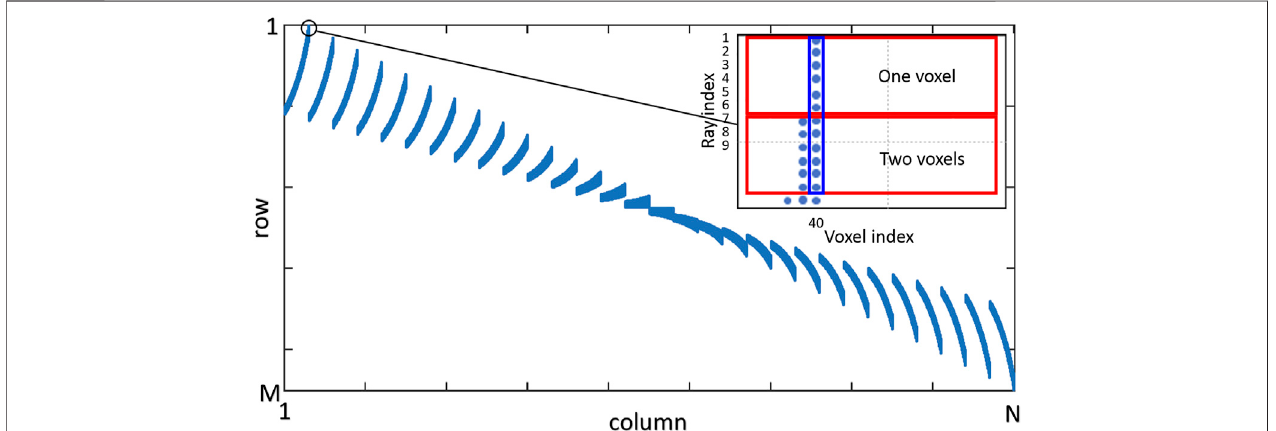
FIGURE 3 | The schematic diagram of the element characteristics of the coef fi cient matrix A .